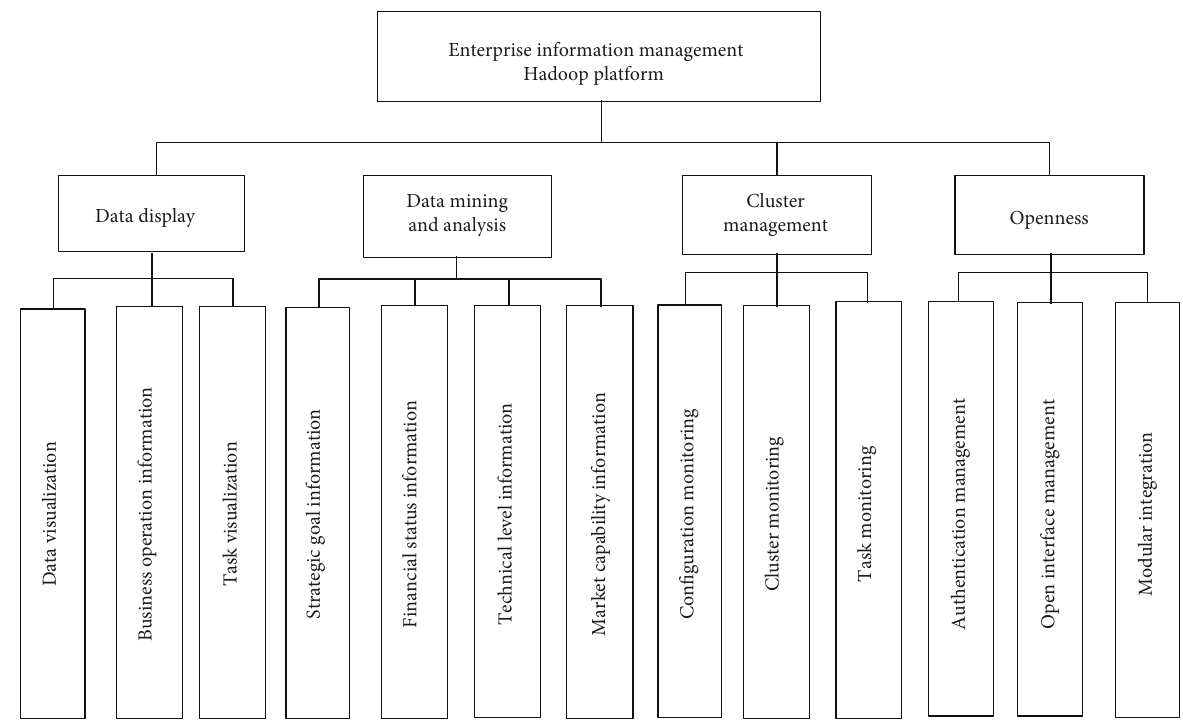
Figure 4: Function design diagram of enterprise information management big data Hadoop